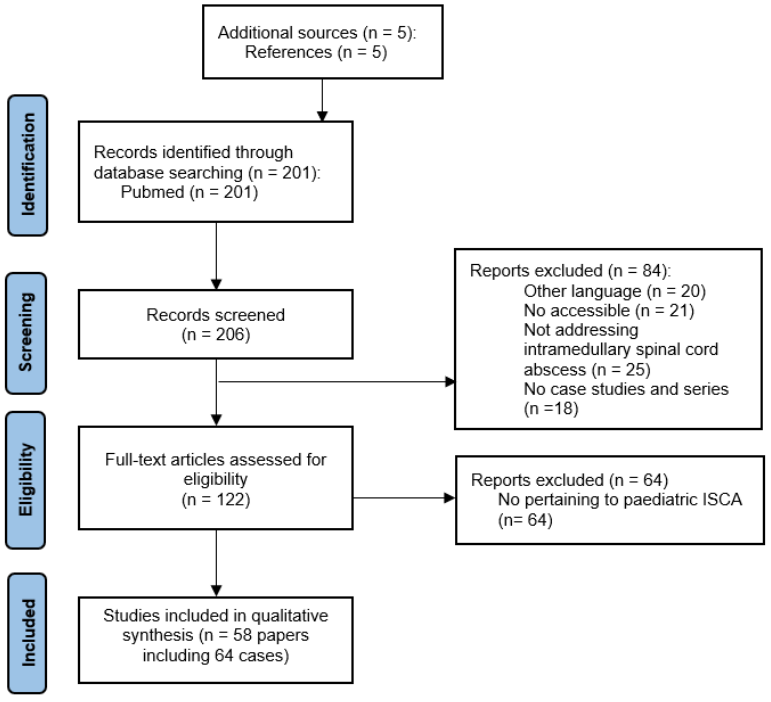
Figure 2. The flow-chart of publications included process.